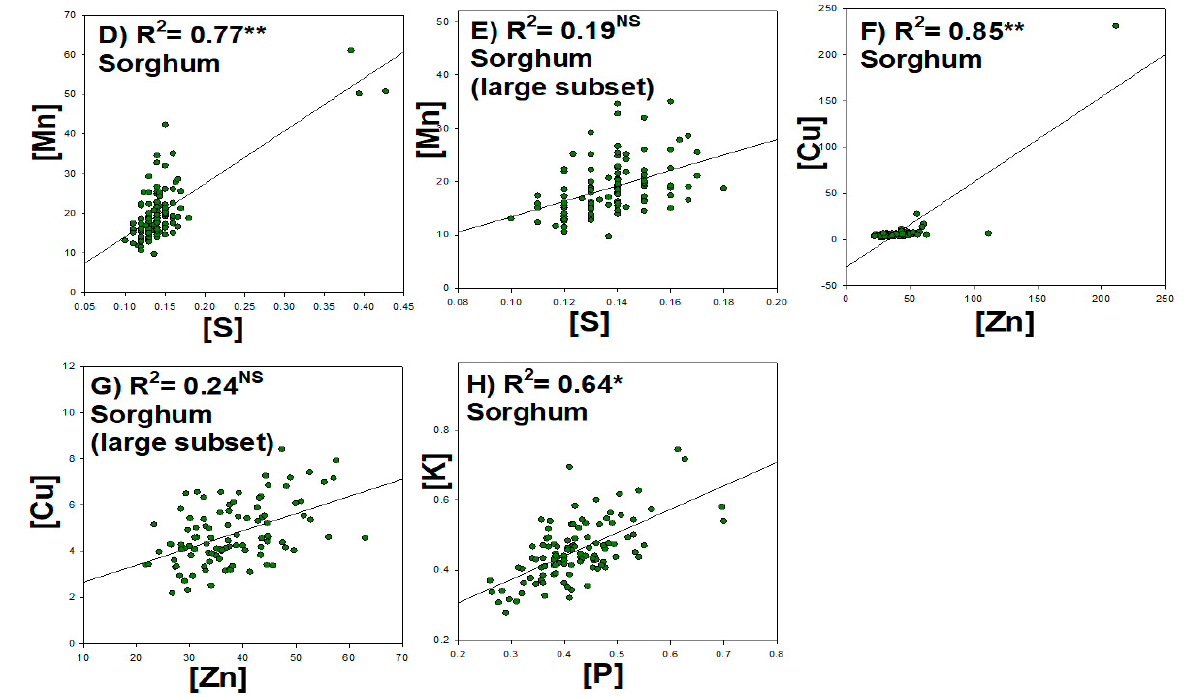
Figure 3. Selected correlations among seed elemental concentrations: ( A ) Flax P and Mg; ( B ) flax P and K; ( C ) sorghum P and Mg; ( D ) sorghum S and Mn; ( E ) sorghum large subset S and Mn; ( F ) sorghum Zn and Cu; ( G ) sorghum large subset Zn and Cu; ( H ) sorghum P and K. * and **, significant at the p < 0.05 and p < 0.01, respectively. NS, not significant, as determined using linear regression; R 2 , linear regression coefficient squared.